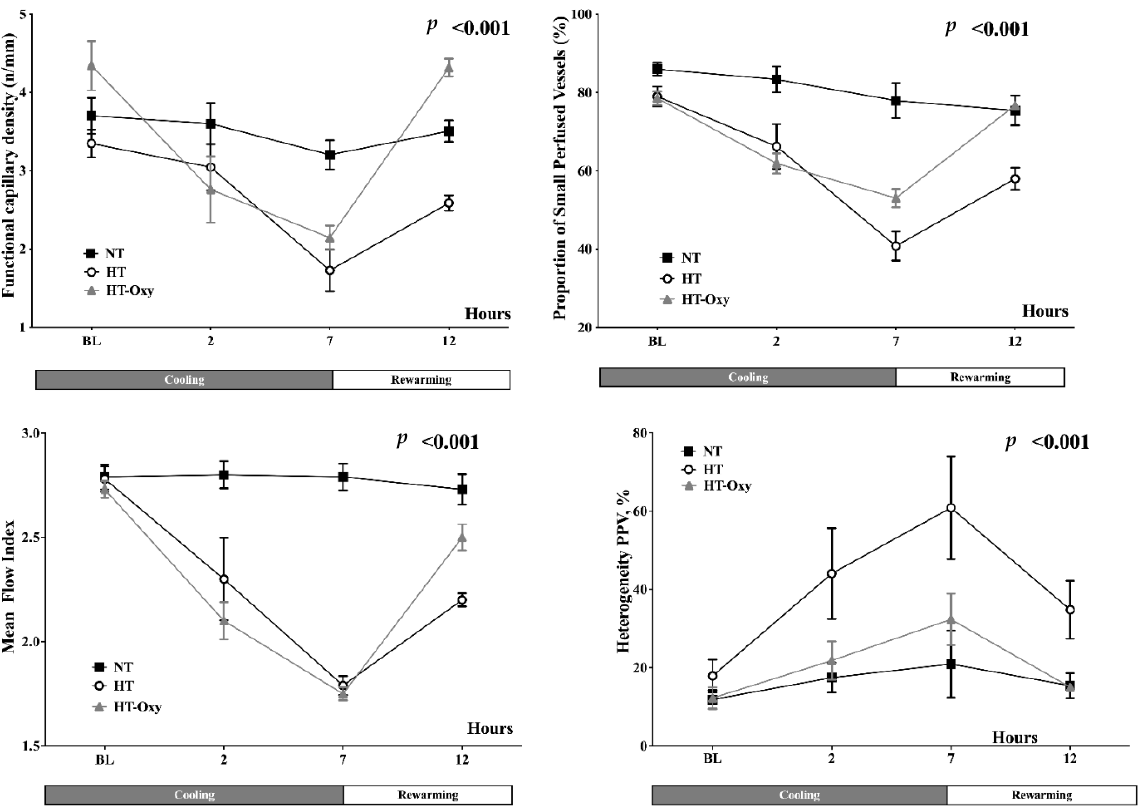
Figure 2. Time-course of microvascular parameters, including the heterogeneity of the proportion of small perfused vessels (PPV) in the normothermia (NT), hypothermia (HT) and hypothermia with PaO 2 levels kept constant with baseline values (HT-Oxy). p -value indicated differences over time between groups.